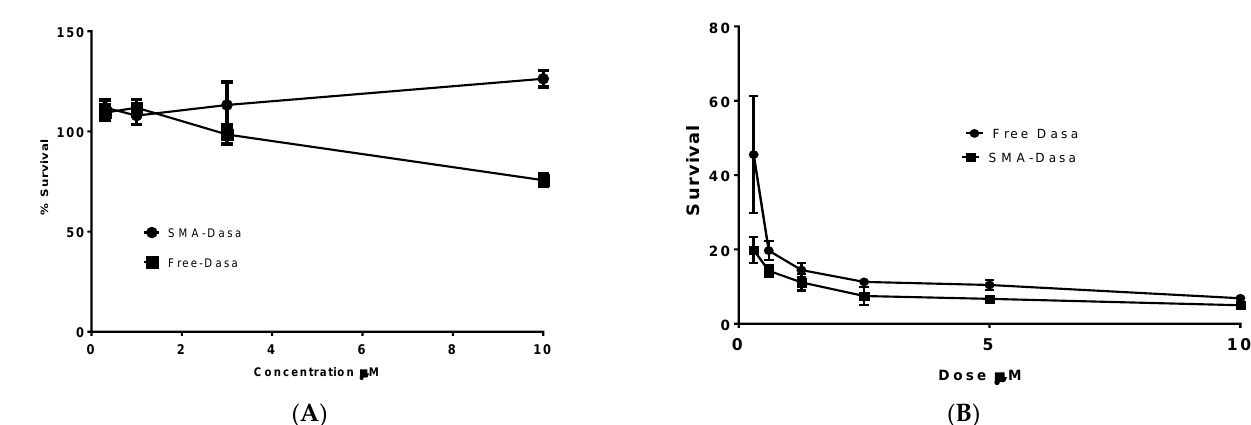
Figure 5. Cytotoxicity of dasatinib and SMA–dasatinib ( A ) against HepG2 cells, ( B ) 4T1 cells after treatment with HepG2. The cells were treated for 48 h with specific concentrations of dasatinib and SMA–dasatinib micelles. The cell number was determined using the SRB assay. Data are expressed as mean ± SEM ( n = 8).